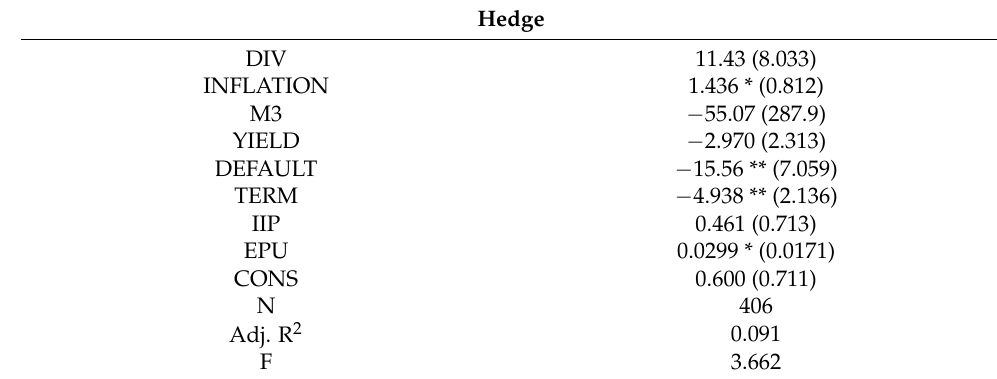
Table 9. Macroeconomic factors and